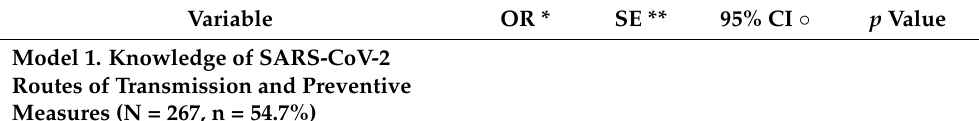
Table 4. Logistic regression model for potential determinants of the outcome of interest (N = 501).